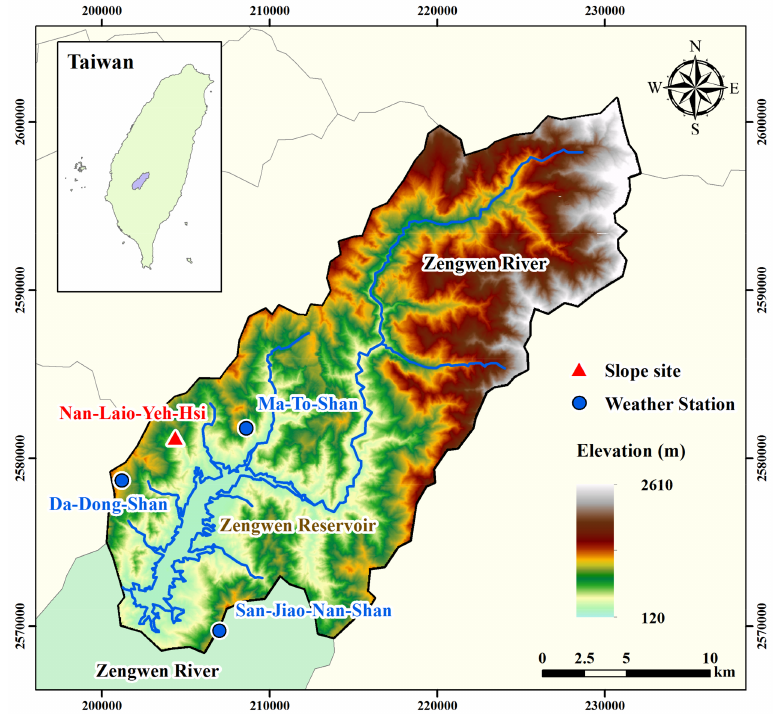
Figure 1. Location of the Zengwen reservoir and the distribution of rainfall